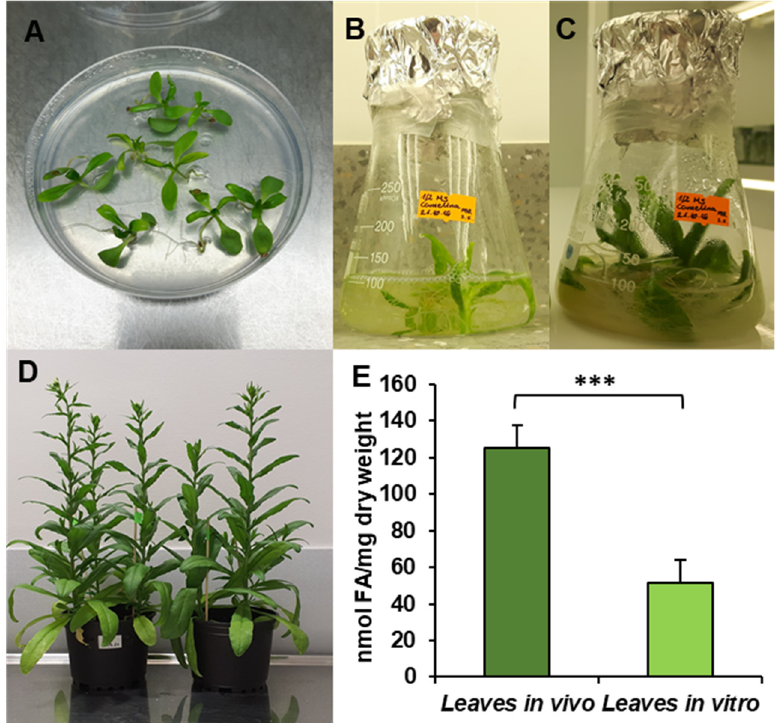
Figure 1. Cultivation conditions— in vitro ( A – C ), in vivo ( D ) and fatty acid contents in C. sativa tested leaves ( E ). ( A ) Ten-day-old seedling before transfer to liquid culture; ( B ) 17-day-old seedling, week after transfer to liquid conditions; ( C ) 24-day-old seedling used for microsomal preparation and lipid analysis; ( D ) in vivo plants used for the experiments; ( E ) contents of fatty acids in leaves cultivated in vivo and in vitro . Mean values and SD are presented (data from at least three independent assays). Asterisks indicate significant difference between fatty acid contents in leaves cultivated in vivo and in vitro in a two-tailed Student’s t -test: *** p ≤ 0.001.